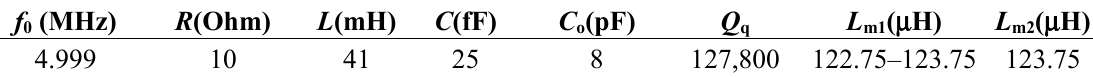
Figure 2. Quartz crystal sensitivity and linearity for k = 0.5, 1, 2 for L L = 123.75 μ H ⋅ k , C m2